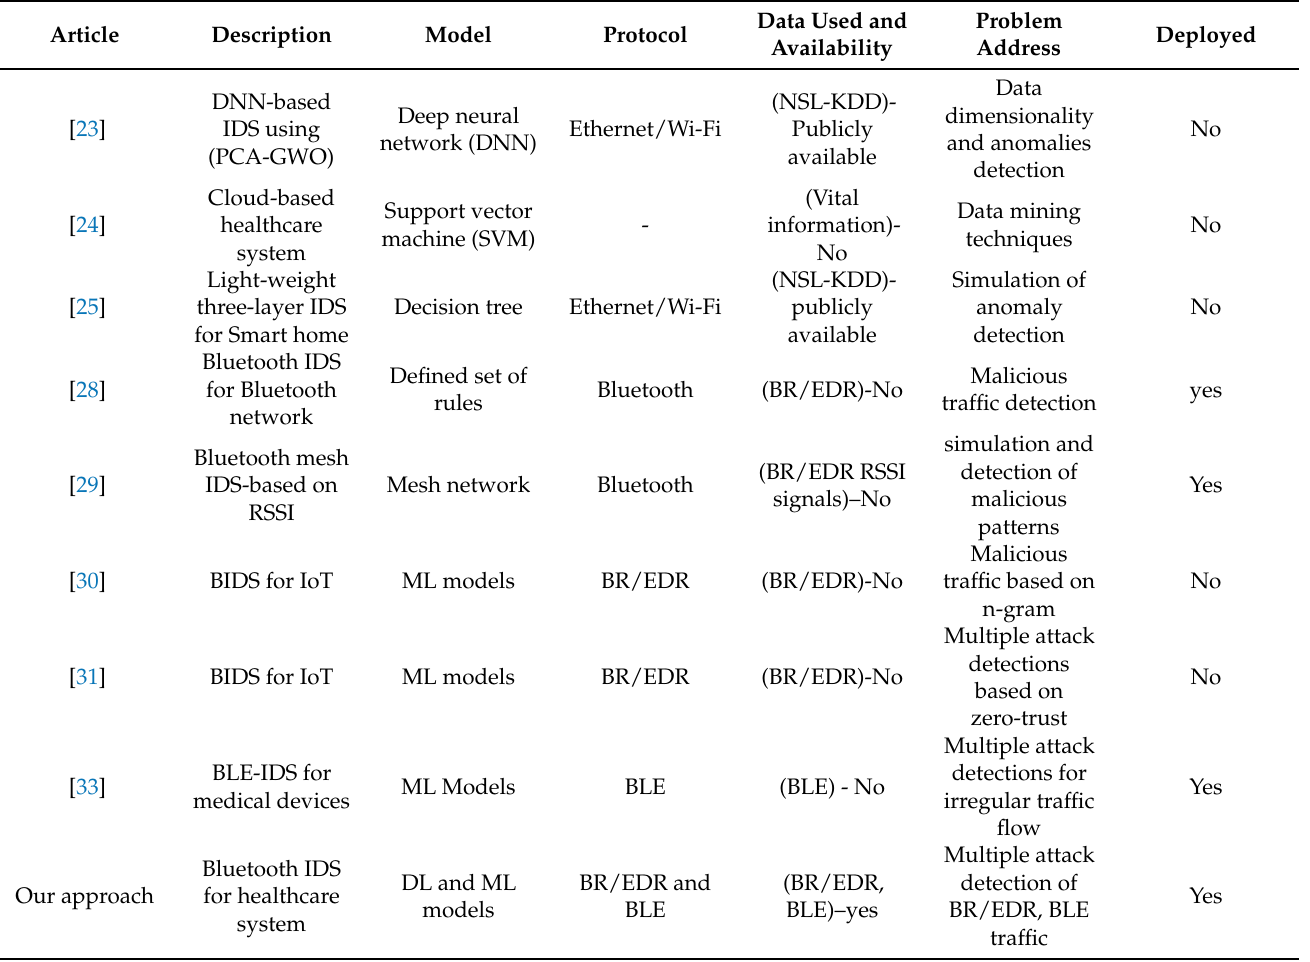
Table 2. Various BIDS approaches in comparison to our proposed models. Our Bluetooth intrusion detection covers both Bluetooth classic and Bluetooth low-energy